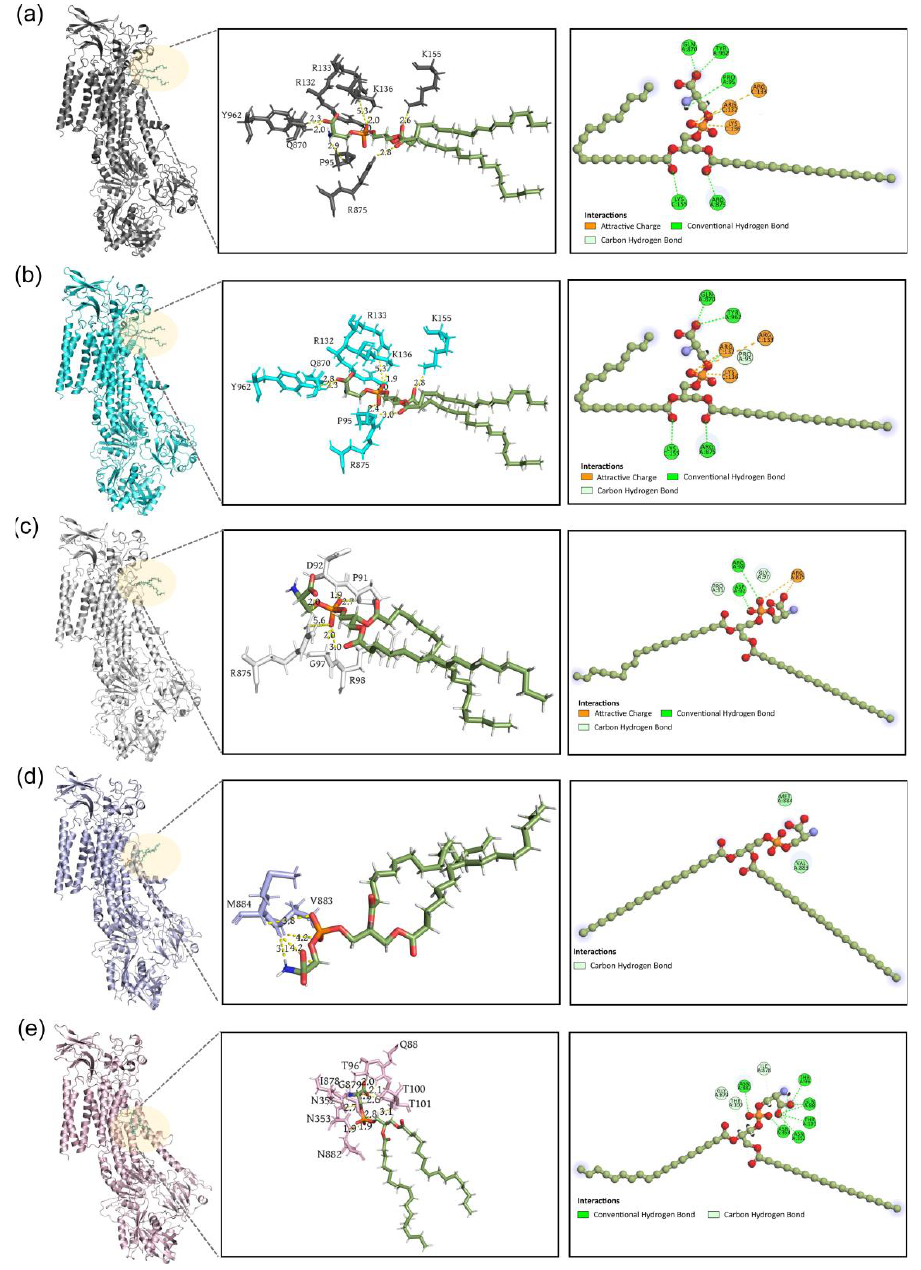
Figure 7. The lipid – protein interactions and the corresponding interactions on the 2D diagram for ( a ) I1 structure (colored dark grey), ( b ) T1 structure (colored cyan), ( c ) I2 structure (colored light grey), ( d ) T2 structure (colored purple) and ( e ) P state (colored pink). For each state, the left panel represents the 3D structure of the complex; the middle panel represents the lipid – protein interac- tions; the right panel represents the interactions on the 2D diagram. After reaching the I2 structure, R875 rotates and forms the electrostatic attraction in- teraction with the phospholipid (Figure 7c). There are relatively strong hydrogen bonds